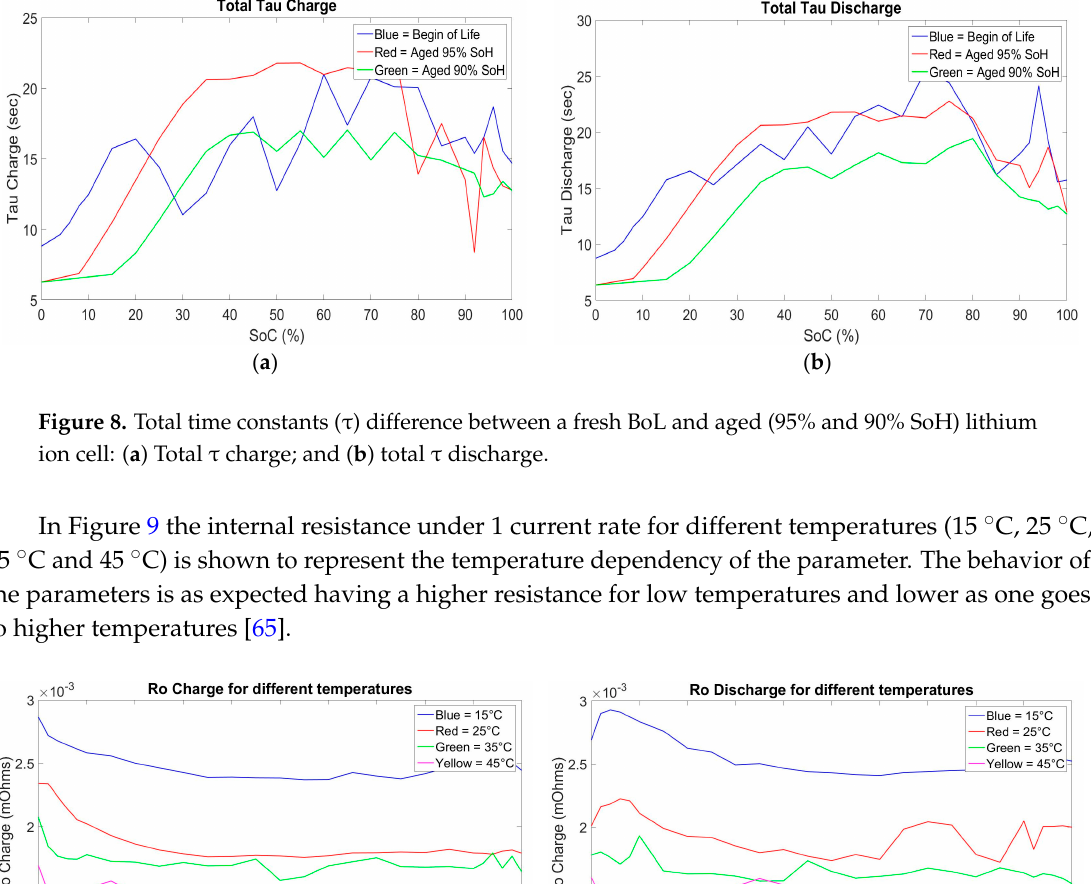
Figure 7. Concentration R p2 difference between a fresh BoL and aged (95% and 90% SoH) lithium ion cell: ( a ) R p2 charge; and ( b ) R p2 discharge.